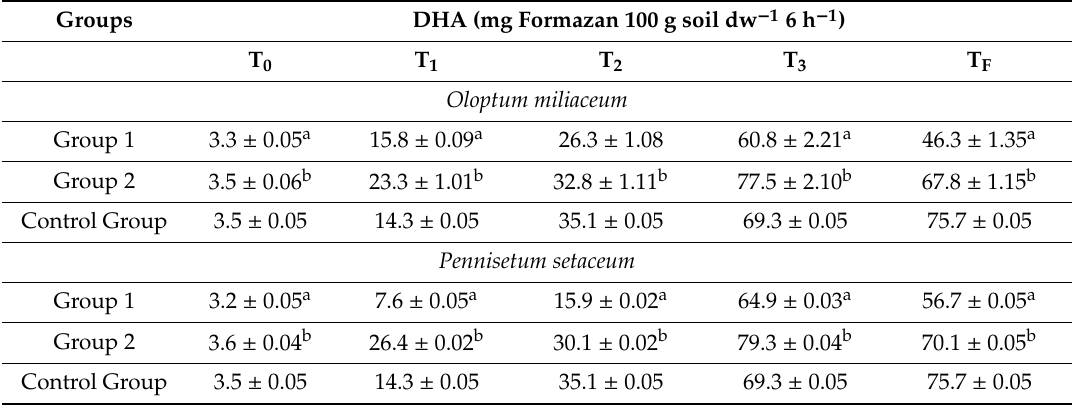
Table 4. Soil DHA in Group 1, 2, and Control Group after 0, 30 (T 1 ), 60 (T 2 ), 90 (T 3 ), and 240 (T F ) days in mesocosms of Oloptum miliaceum and Pennisetum setaceum . Values represent mean ± SE. Di ff erent letters indicate means that are significantly di ff erent from each other (Duncan’s test, p <